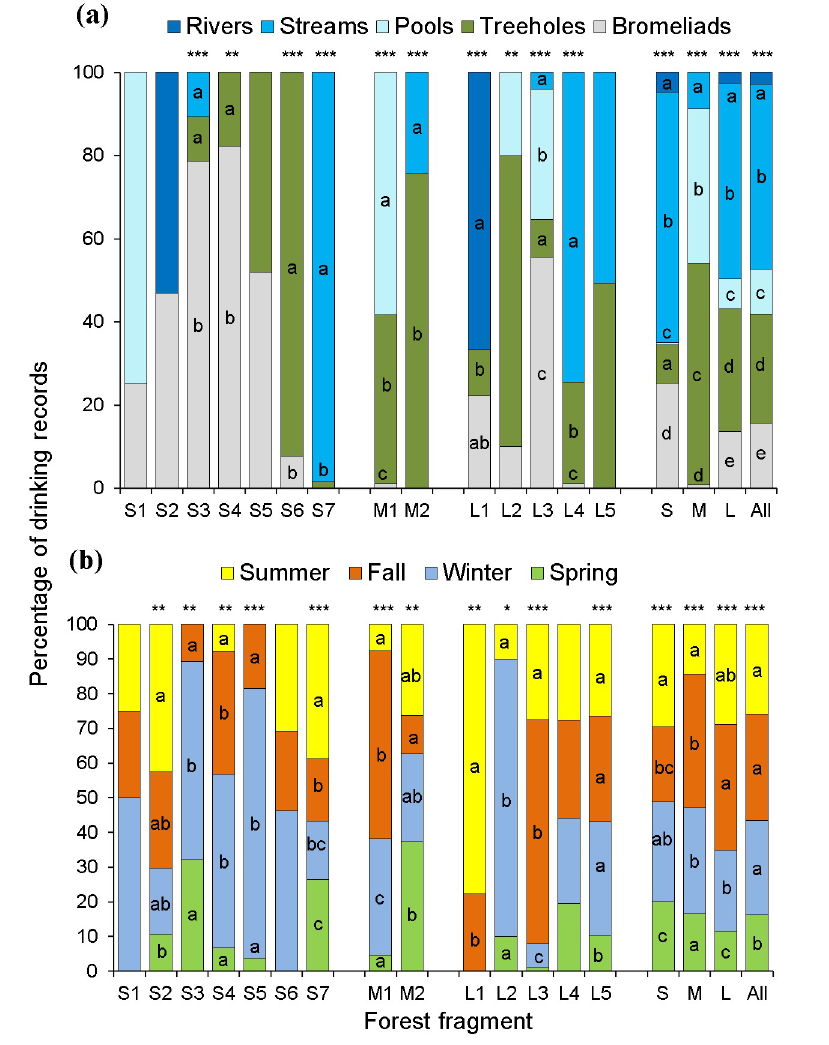
Fig 2. Percentage of drinking records in 14 brown howler groups per water source (a) and season (b). Different lower-case letters in the middle of each bar indicate significant differences in the number of records. Asterisks on the bars indicate the significance level according to Chi-square tests for proportions: � P � 0.05, �� P < 0.01, ��� P < 0.001. The proportion of records at the forest size level (small = S, medium = M, and large = L) and in the pooled dataset (All) is indicated in the four bars to the right. Water sources—rivers: Permanent water currents > 4-m in width and > 1-m in depth; streams: Seasonal water currents < 2-m in width and < 1-m in depth; treeholes: 10-40-cm diameter holes in trunks or large branches; bromeliads: Water stored in the rosette of epiphytic bromeliads. Significant differences in the proportion of records between water sources or seasons within each fragment are indicated with different lower-case letters in the bars. When proportion contrasts tests did not detect differences, no letter is shown. N = 1,128 records in (Fig 2a) and 1,131 records in (Fig 2b).